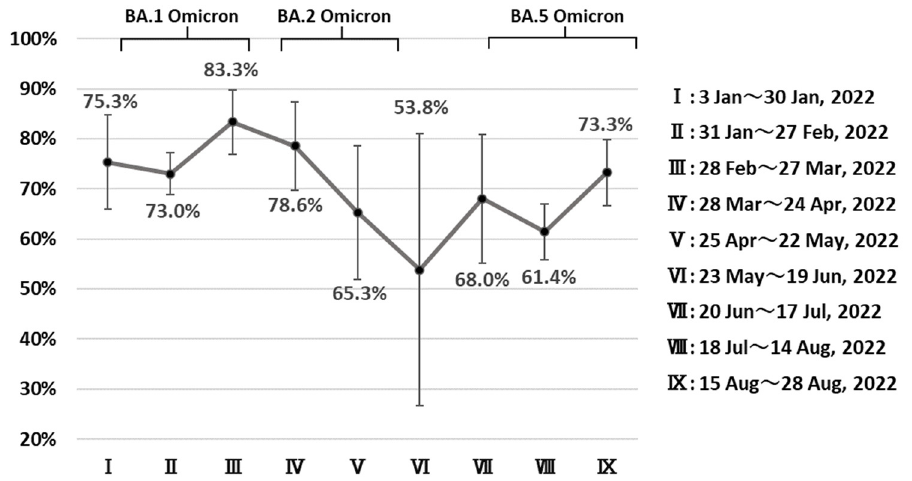
Figure 3. Trend in the proportion of deaths with COVID‑19 among deceased individuals aged ≥ 40 years who were diagnosed with COVID‑19 between 3 January and 28 August 2022, in Japan. Graph Indicates dominant period ( ≧ 85%).